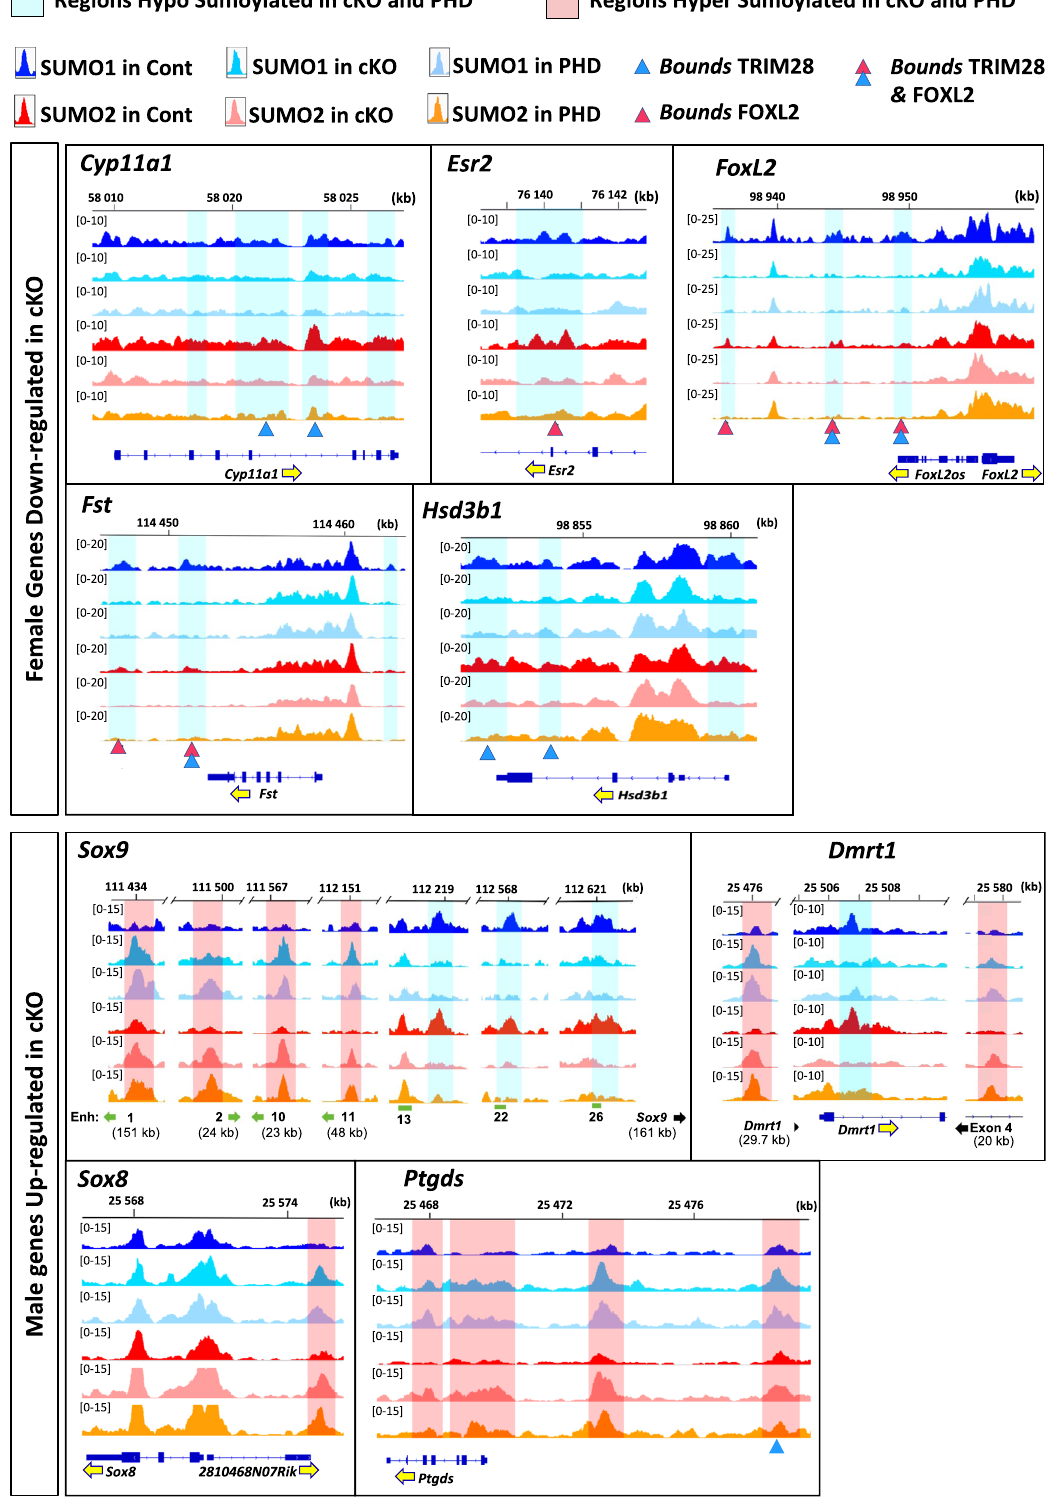
Fig. 6 | Examples of SUMOylation status (SUMO1 and 2) in control and mutant ovaries of genes the expression of which is altered in Trim28 cKO ovaries. Upper panel: ovarian-speci fi c genes downregulated in Trim28 cKO ovaries. Lower panel: testicular-speci fi c genes upregulated in Trim28 cKO ovaries. Cont: control. cKO : Trim28 cKO . PHD : Trim28 Phd/cKO . Yellow arrows indicate the gene orientation. Light